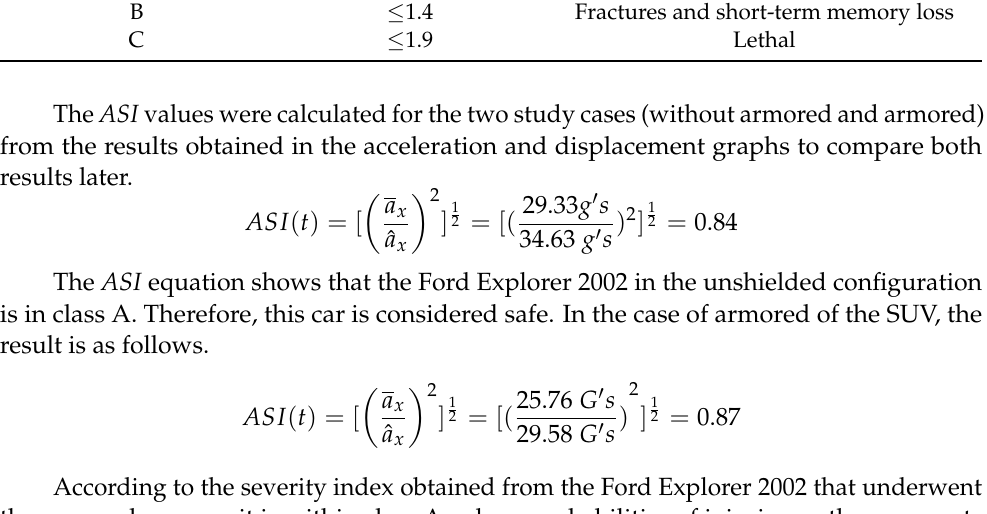
Table 7. ASI index. Class ASI Level Injuries A ≤ 1.0 Minor injuries B ≤ 1.4 Fractures and short-term memory loss C ≤ 1.9